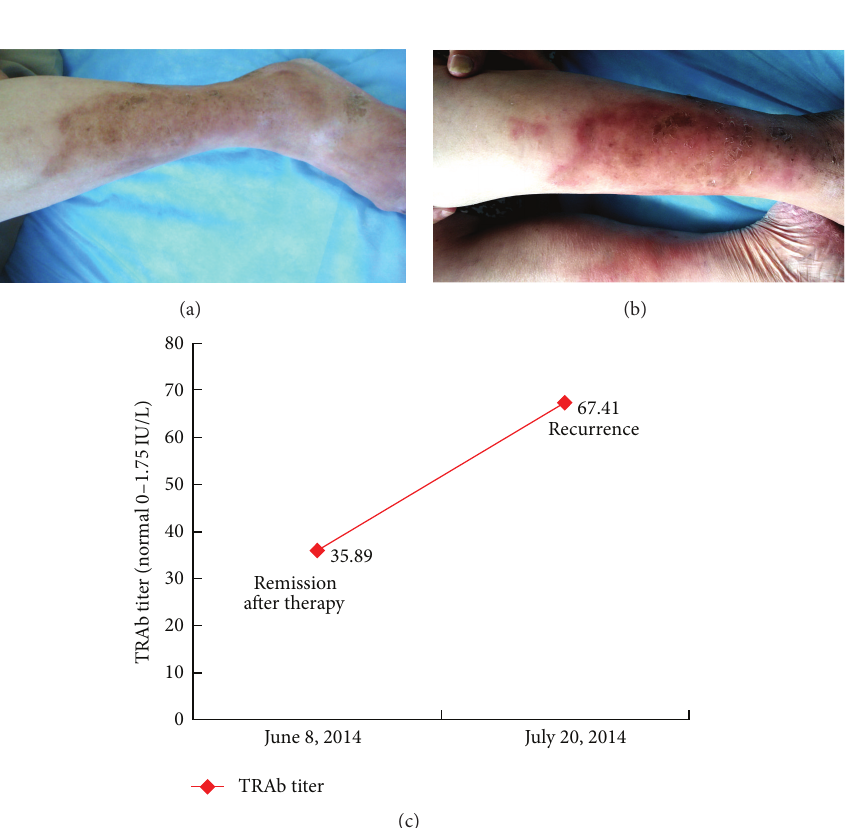
Figure 12: The serum TRAb level increased when the lesion recurred. (a) On June 8, 2014, the lesion on the left lower leg was at remission after therapy and pigmented. (b) On July 20, 2014, the lesions on both lower legs recurred and presented as erythematous, diffuse swelling. (c) The serum TRAb level was 35.89 IU/L when remission after therapy on June 8,2014 and increased to 67.41IU/L when recurrence on July 20,